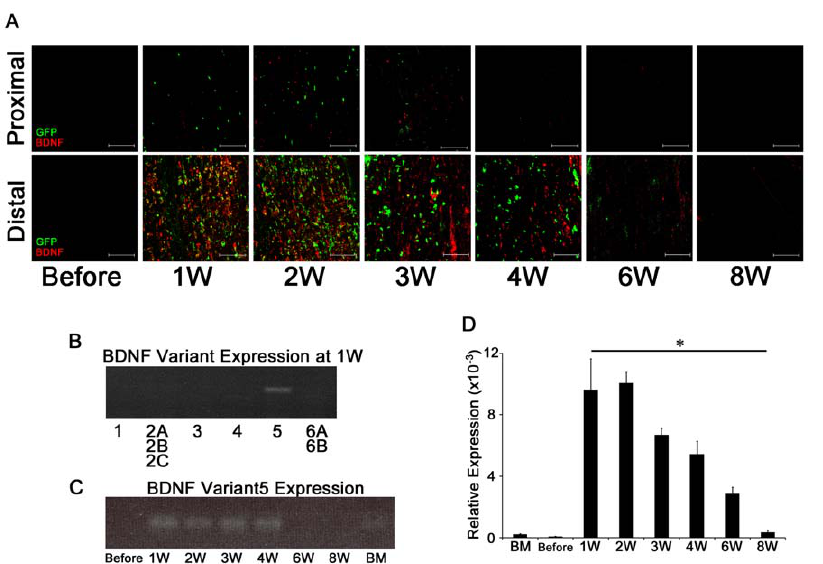
Figure 2. Effect of BMDCs in sciatic nerve recovery from injury. A ) GFP and BDNF immunohistochemistry in the C57BL/6 mice (BDNF + / + ). Bar indicates 100 m m. B ) The expression of the BDNF splice variants at 1 week. C ) The expression of BDNF variant 5 throughout the experimental period. D ) Relative expression level of BDNF variant 5 in the sciatic nerve from C57BL/6 mice (BDNF + / + ). (n=10). Data are the mean 6 SEM. * p , 0.05.